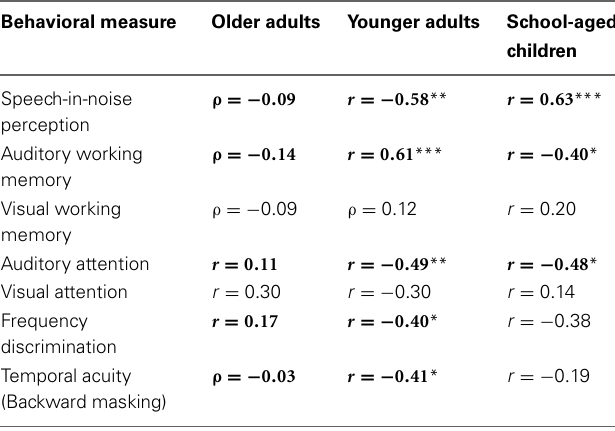
Table summarizes Pearson’s r or Spearman ρ correlation values between years of musical experience and behavioral measures. Bolded values indicate skills where musicians have behavioral advantages over non-musicians (Strait et al., 2010, 2012b; Parbery-Clark et al., 2011a). Skills that correlate with years of